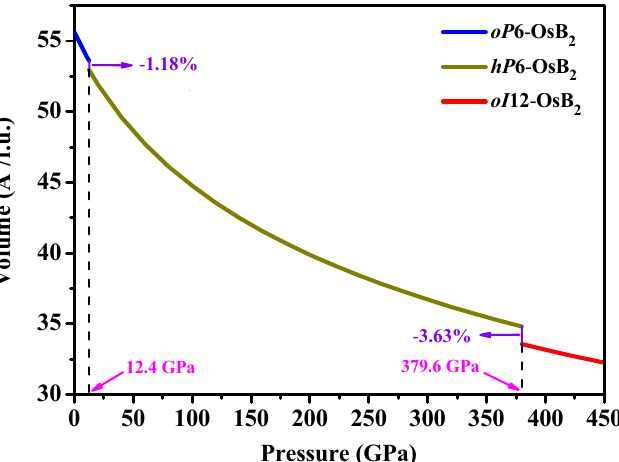
Figure 4. The equation of states ( P – V curve) of OsB 2 . The purple lines indicate the volume reduction at 12.4 and 379.6 GPa.